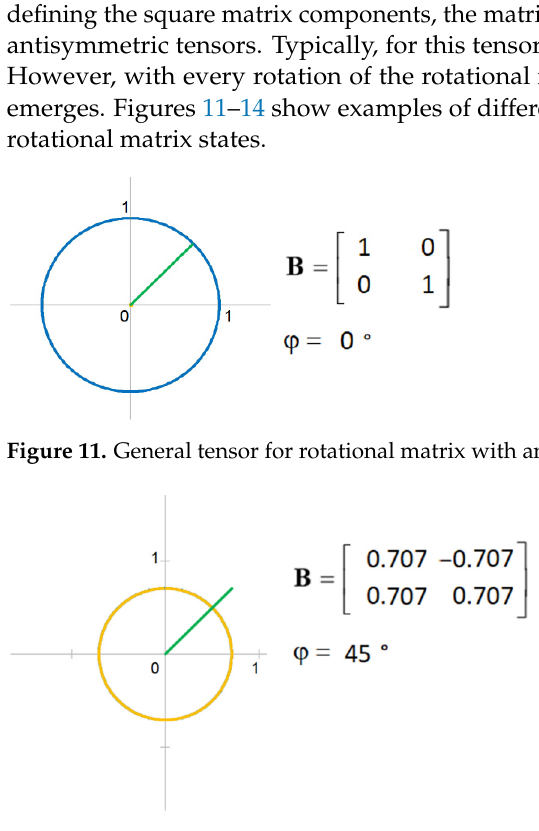
Figure 13. General tensor for rotational matrix with angle 𝜑 = 100° . Figure 14. General tensor for rotational matrix with angle 𝜑 = 20° . As can be seen, in all cases, the tensor shape is made of the diagonal matrix compo- nents (𝑎 (cid:2869)(cid:2869) , 𝑎 (cid:2870)(cid:2870) ) and (𝑎 (cid:2869)(cid:2870) , 𝑎 (cid:2870)(cid:2869) ) , which give rise to two concentric circles. 6. Golden Section in Tensor Visualization Shape proportions created by diagonal symmetric tensor components depend solely on the angle of the initial vector. With the initial state 𝛼 = 0° , the maximum values of ten- sor component parts in the x -axis direction display the golden section ratio 𝜑 (Figure 15). 𝑎 (cid:2869)(cid:2869) (cid:3299) (cid:3171)(cid:3159)(cid:3182) − 𝑎 (cid:2869)(cid:2870) (cid:3299) (cid:3171)(cid:3159)(cid:3182) 𝑎 (cid:2869)(cid:2869) (cid:3299) (cid:3171)(cid:3159)(cid:3182) = 𝜑 = 0.618 …